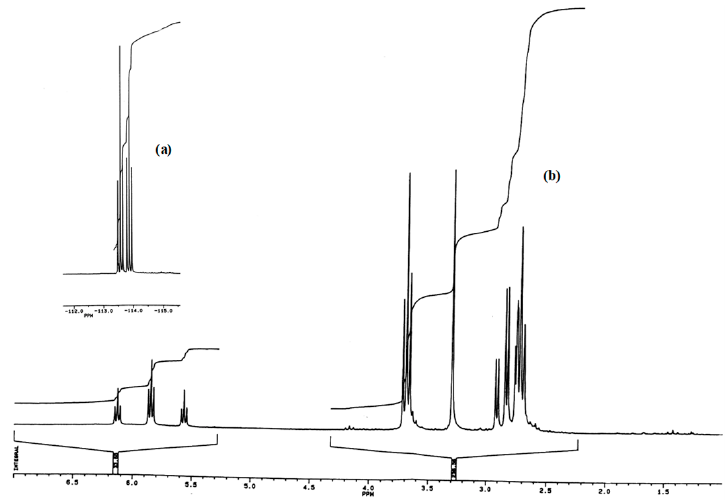
Figure 1. NMR spectra of HOCH 2 CH 2 SCH 2 CF 2 H monoadduct: ( a ) 19 F NMR spectrum and ( b ) 1 H NMR spectrum, recorded in CDCl 3 at 20 °C.